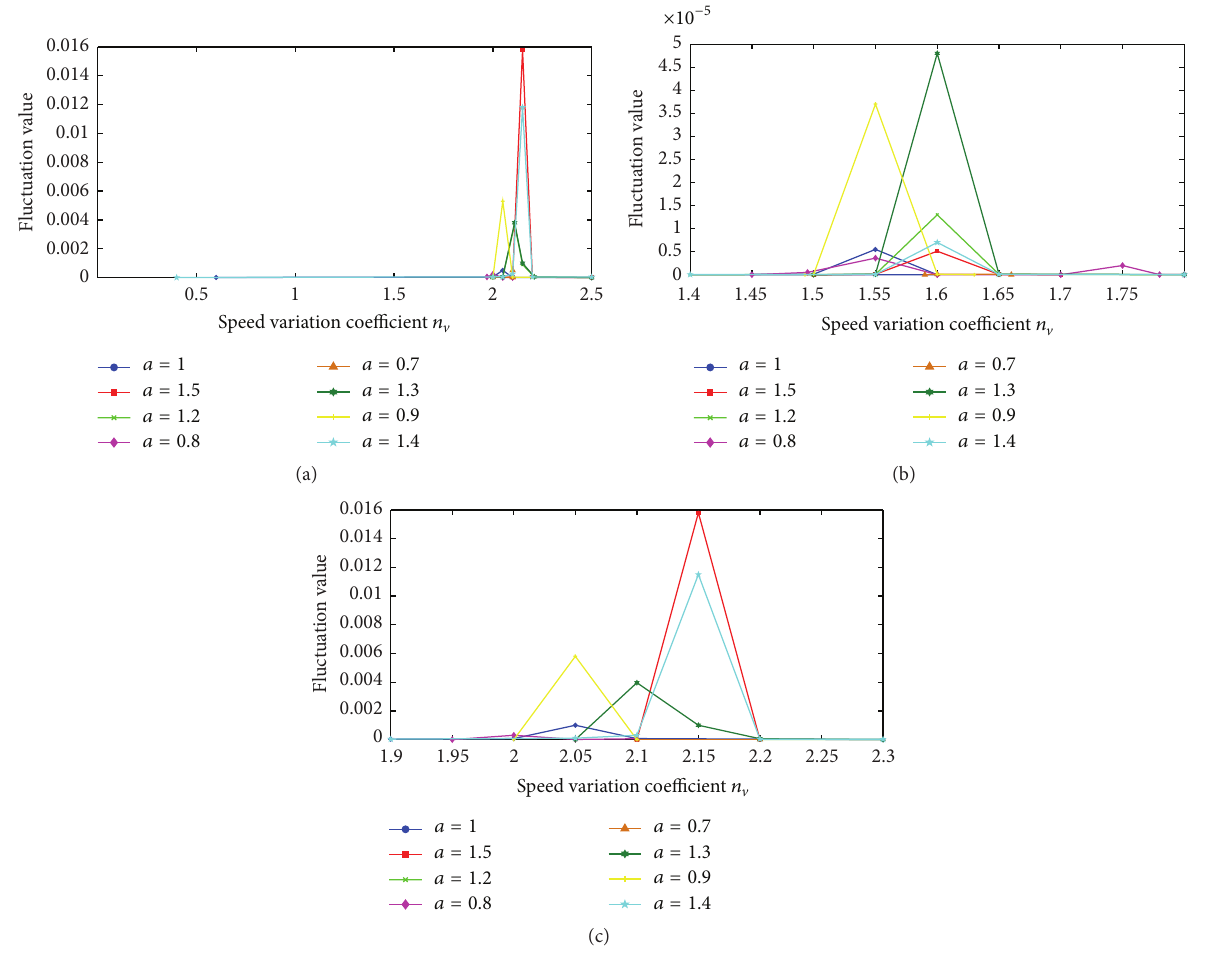
Figure 5: Gear transmission error 𝑥 𝑛